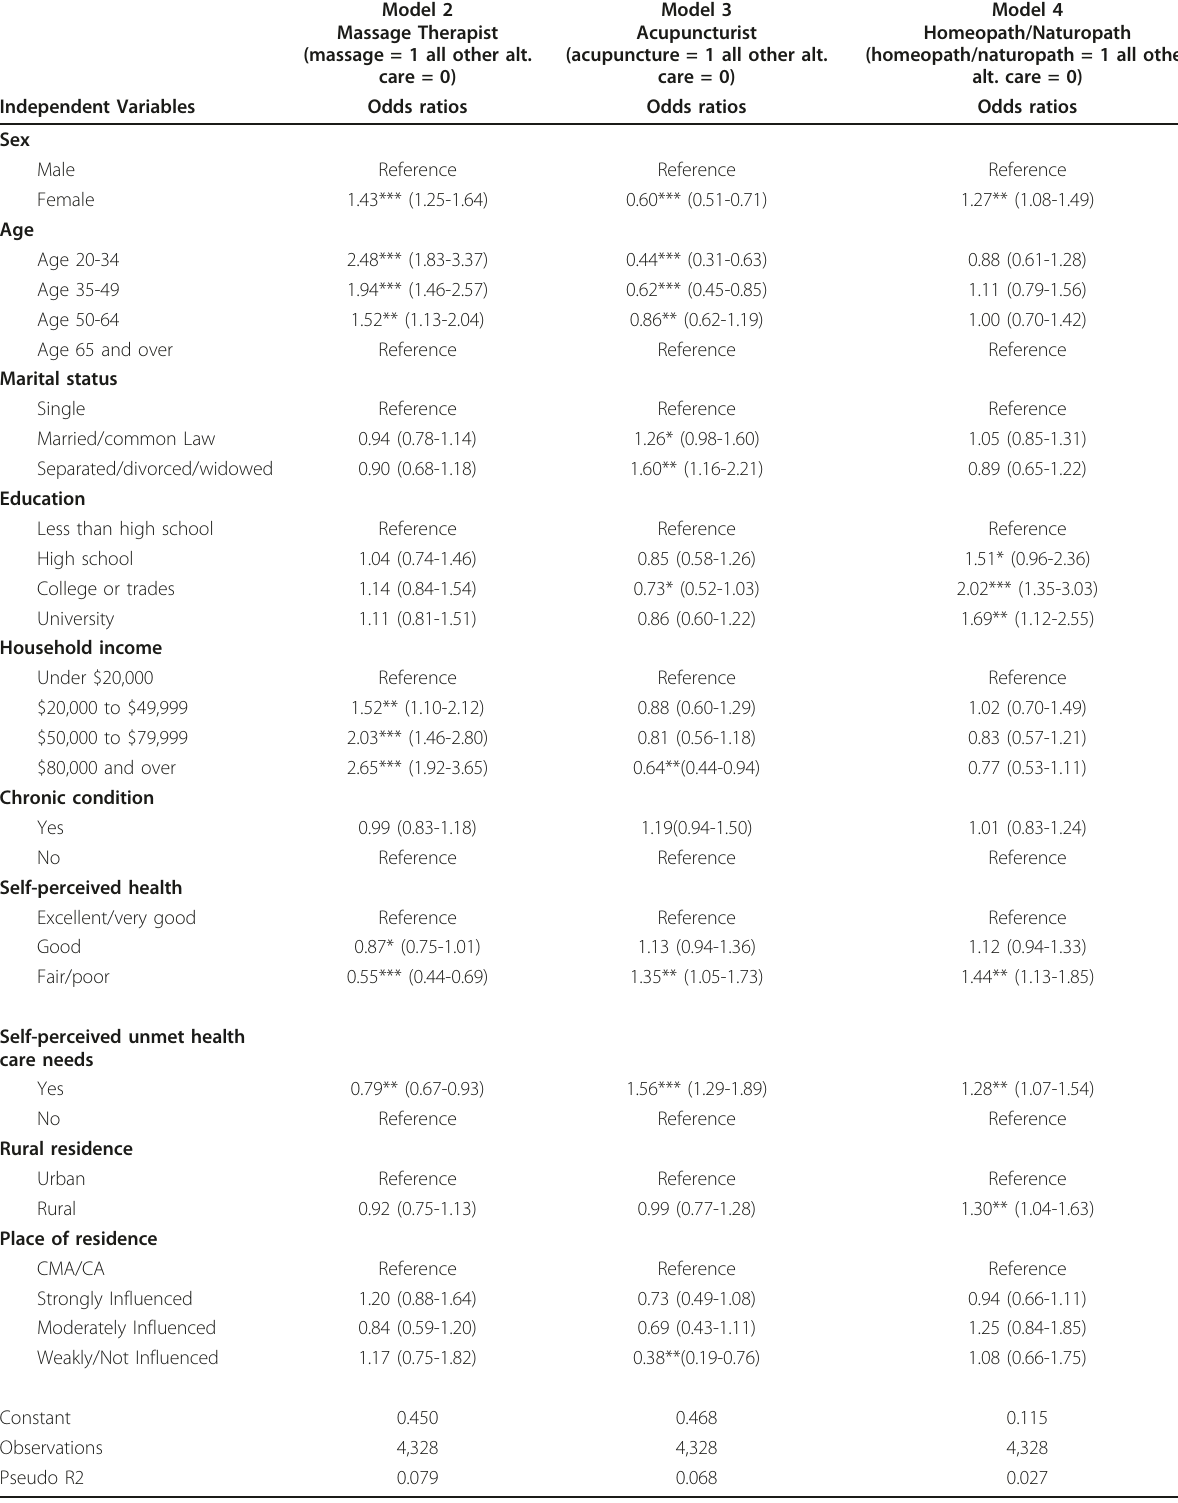
Table 7 Results of Logistic Regression Analyses Alternative Health Care Consultations: Massage